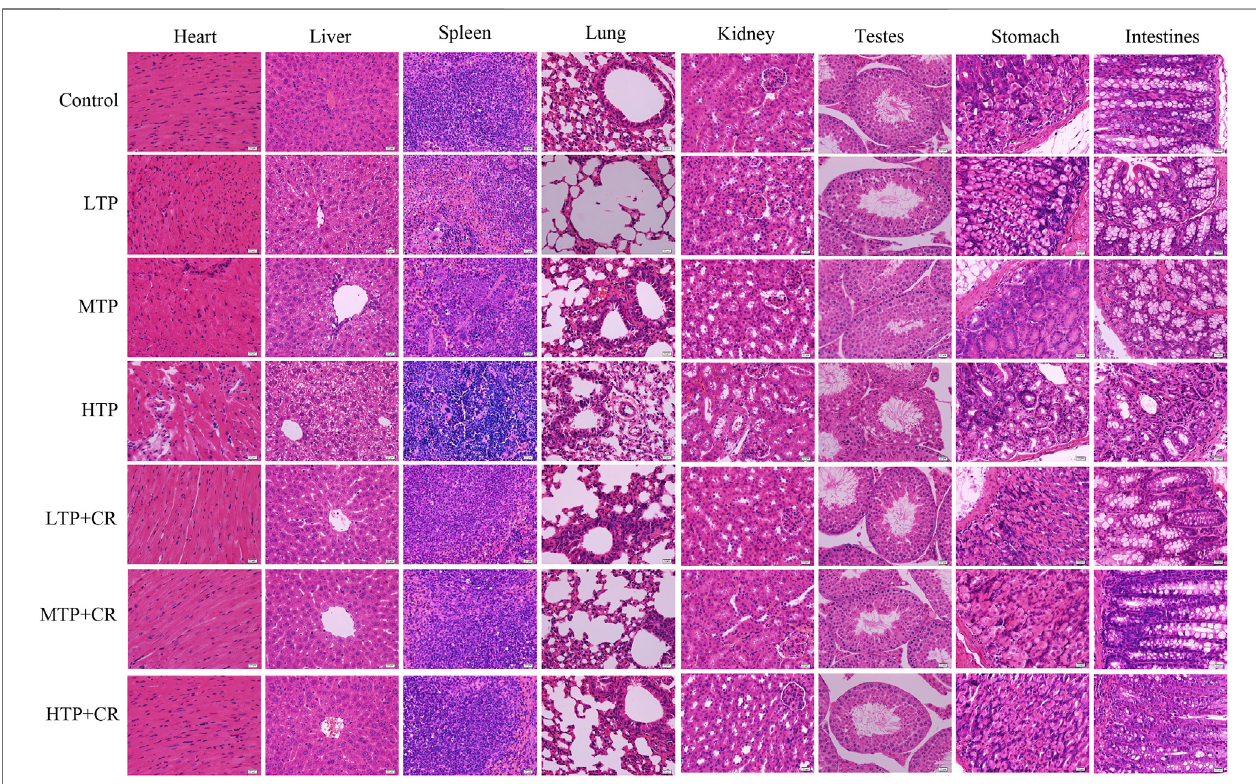
FIGURE 8 | Histopathological observations of H&E staining on the main visceral organs of the mice. Images were obtained at 400X magni fi cation (scale bar = 20 μ m).